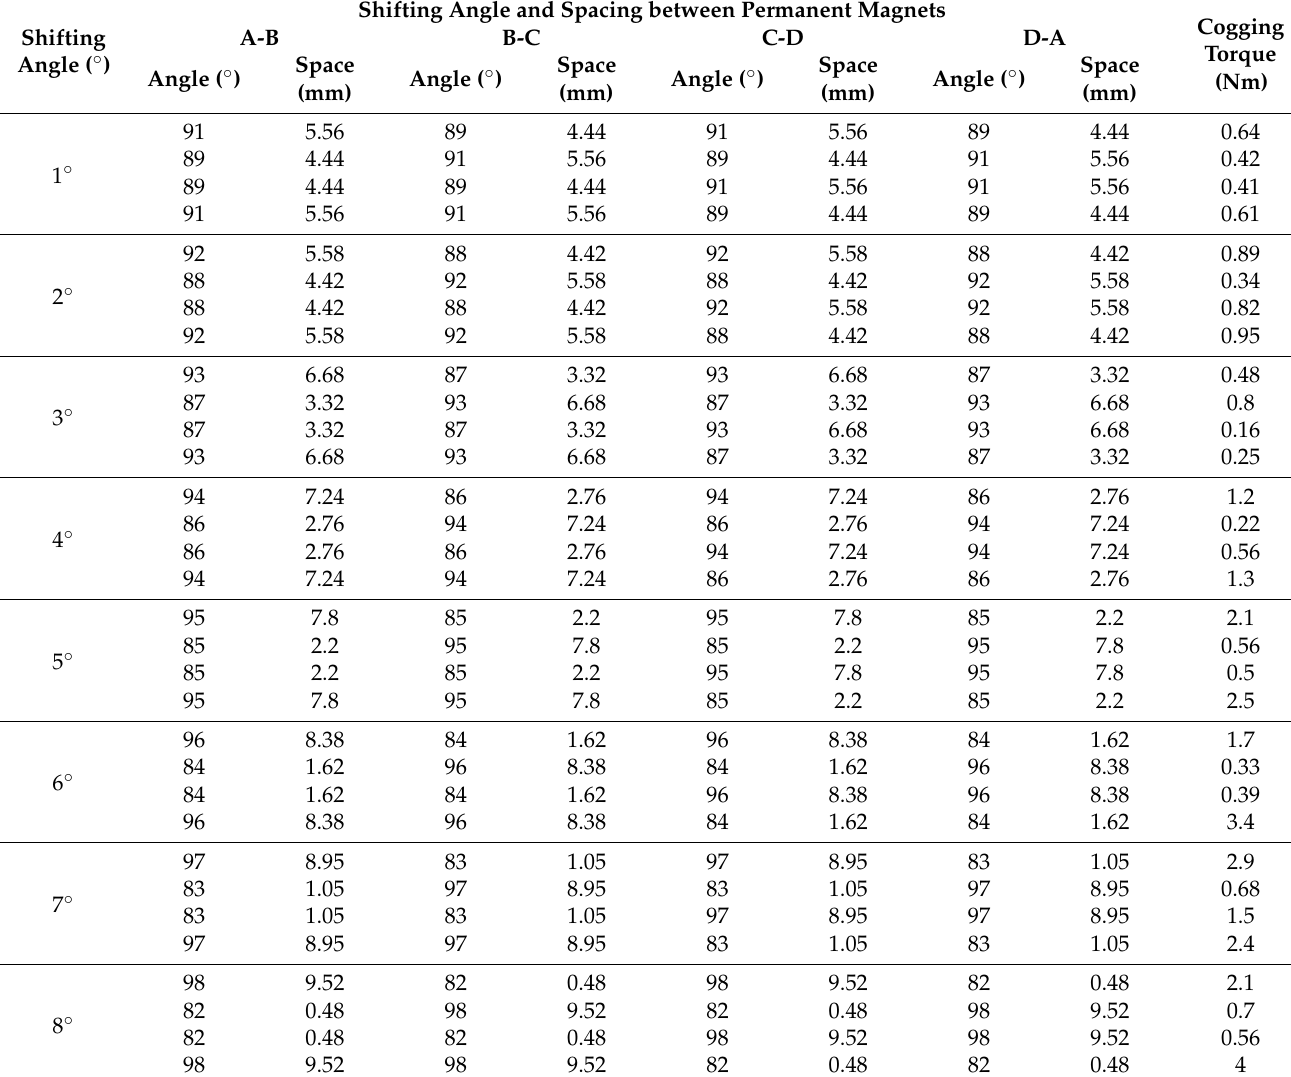
Table 4. Tabulation of results of cogging torque with variation of magnet shifting from 1 ◦ to 8 ◦ .